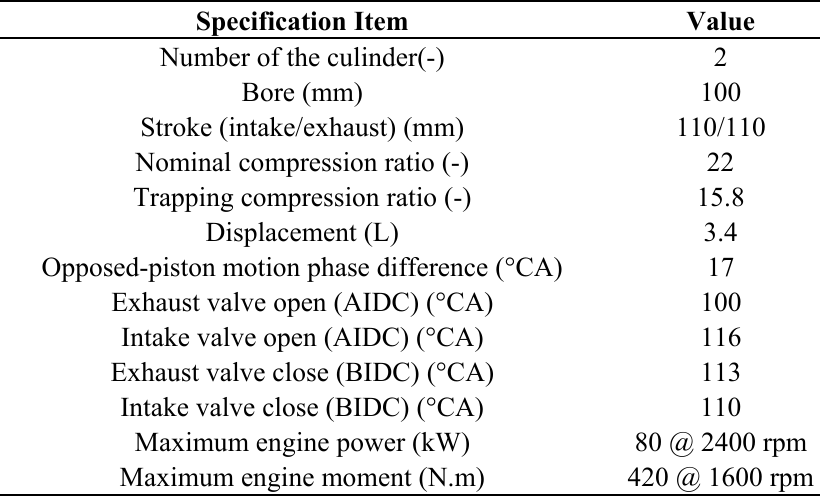
Figure 1. OPFC diesel engine concept. Table 1. OPFC diesel engine